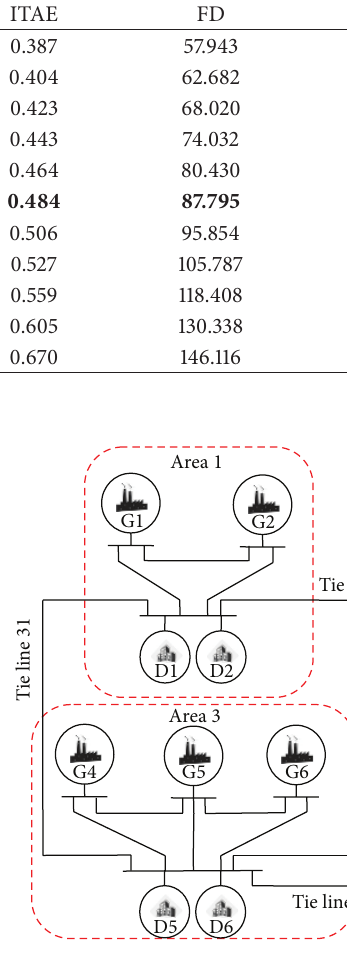
Figure 7: Schematic diagram of a four-area system in restructured power market for Case